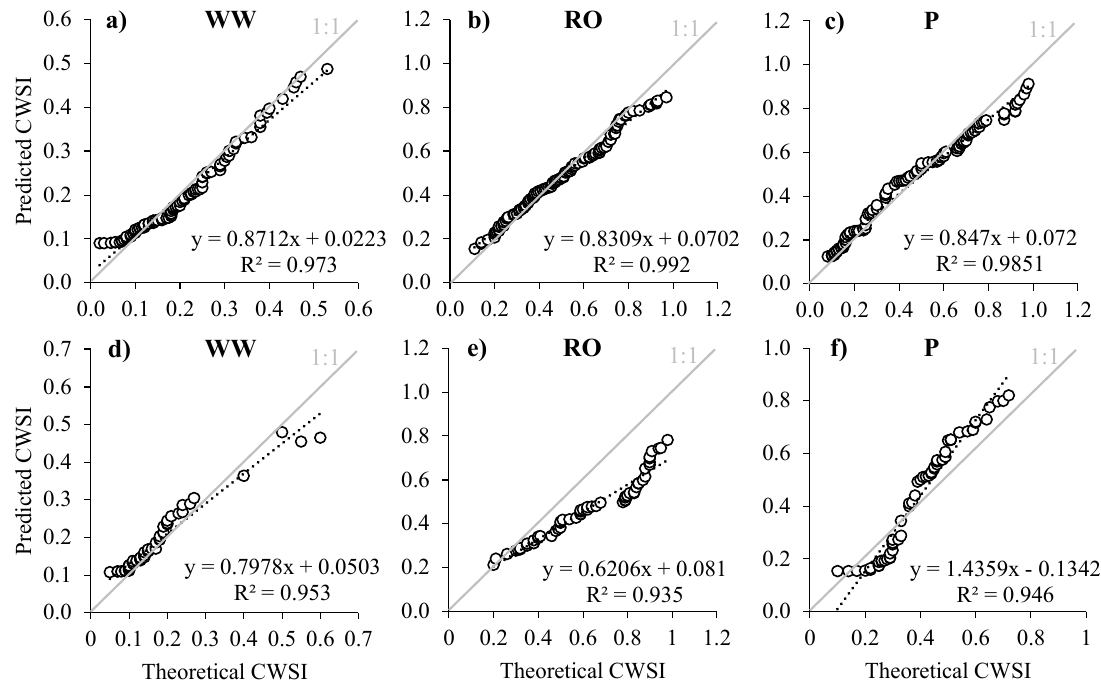
Figure 7. Comparison of theoretical and predicted CWSI values for the KSOM in the training and testing periods from ( a – c ) and from ( d – f ), respectively. Table 4. Testing statistics of KSOM model. The coefficient of determination (R 2 ), root mean square